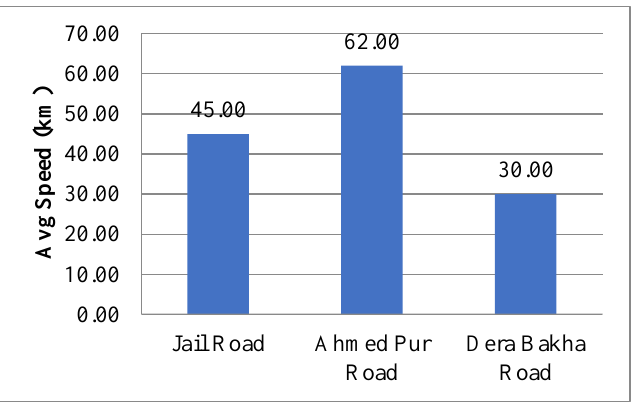
Fig. 4. Average speed values